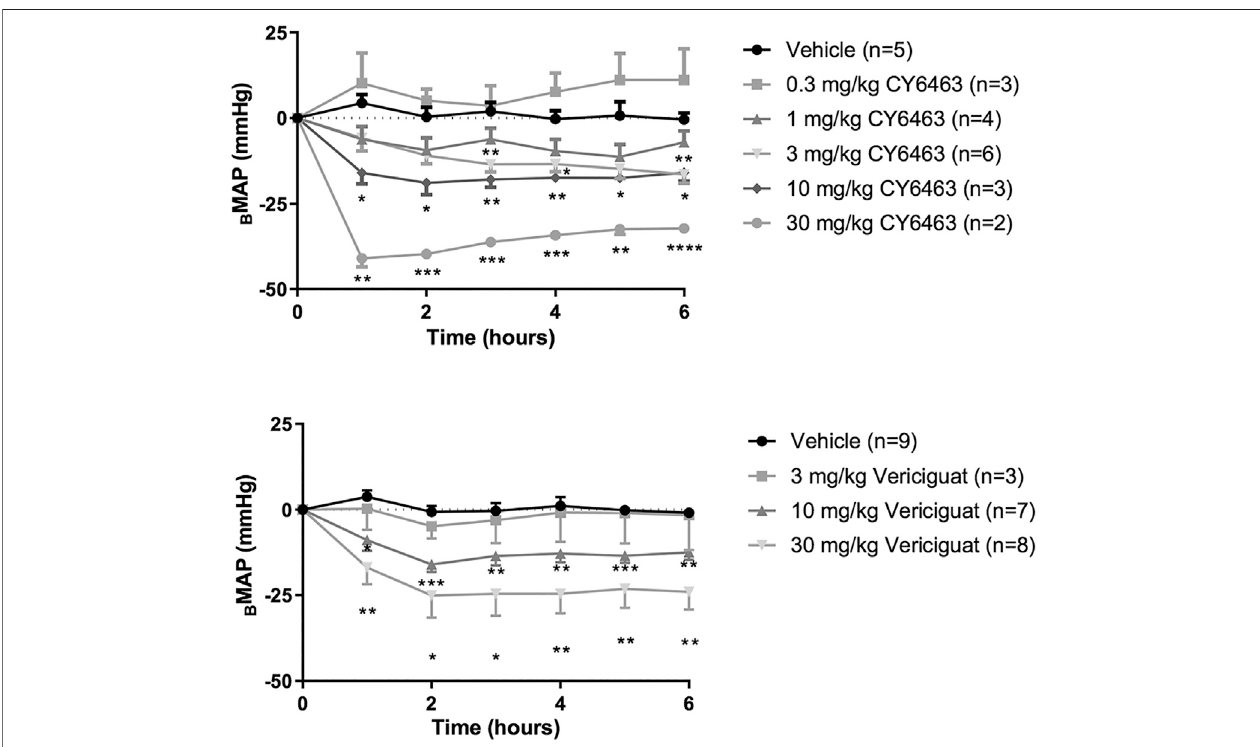
FIGURE 2 | Effects of CY6463 and vericiguat on blood pressure. (A) Change from baseline MAP ( Δ B MAP) in rats treated with CY6463. (B) Δ B MAP in rats treated with vericiguat. All annotated Dunnett ’ s post hoc tests were compared to vehicle-treated rats * p < 0.05, ** p < 0.01, *** p < 0.001 and **** p < 0.0001. All data are expressed as mean ±